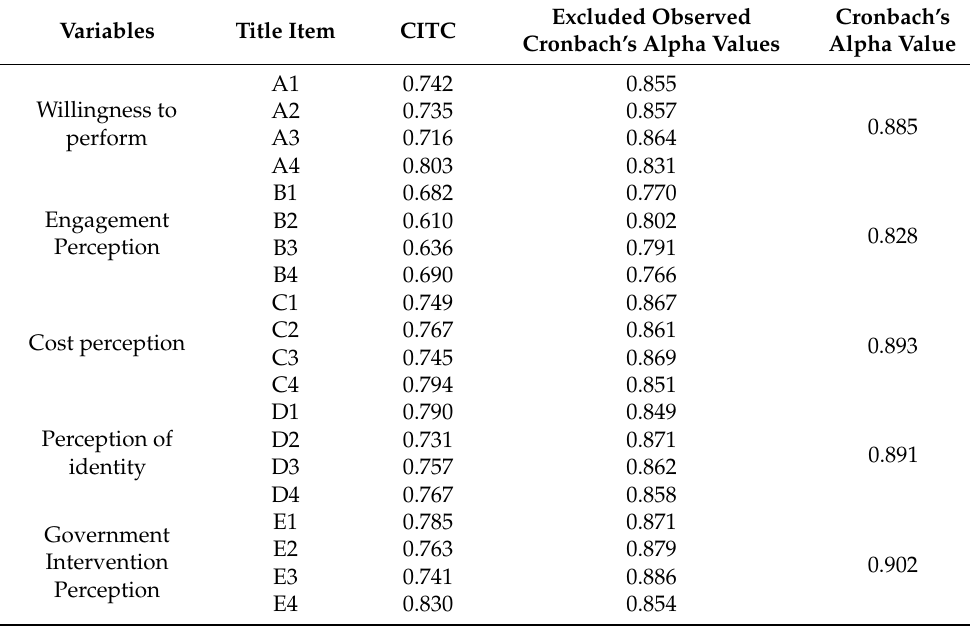
Table 4. Reliability analysis of variables in the